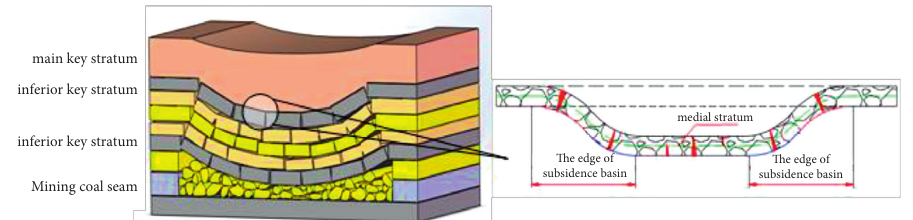
Figure 1: Sketch map of rock stratum’s tensile deformation.